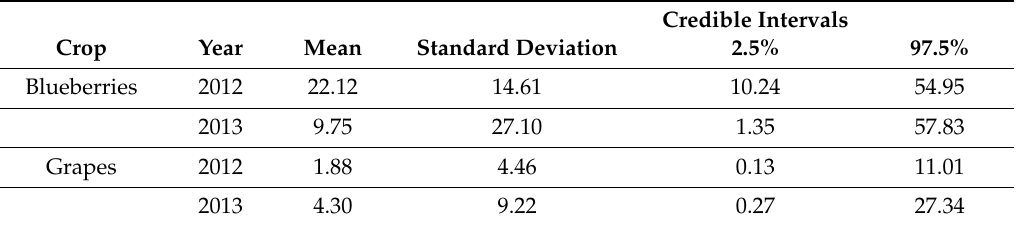
Table 5. Estimates of fruit-eating bird abundance in Michigan blueberries and grapes. Means are per point count